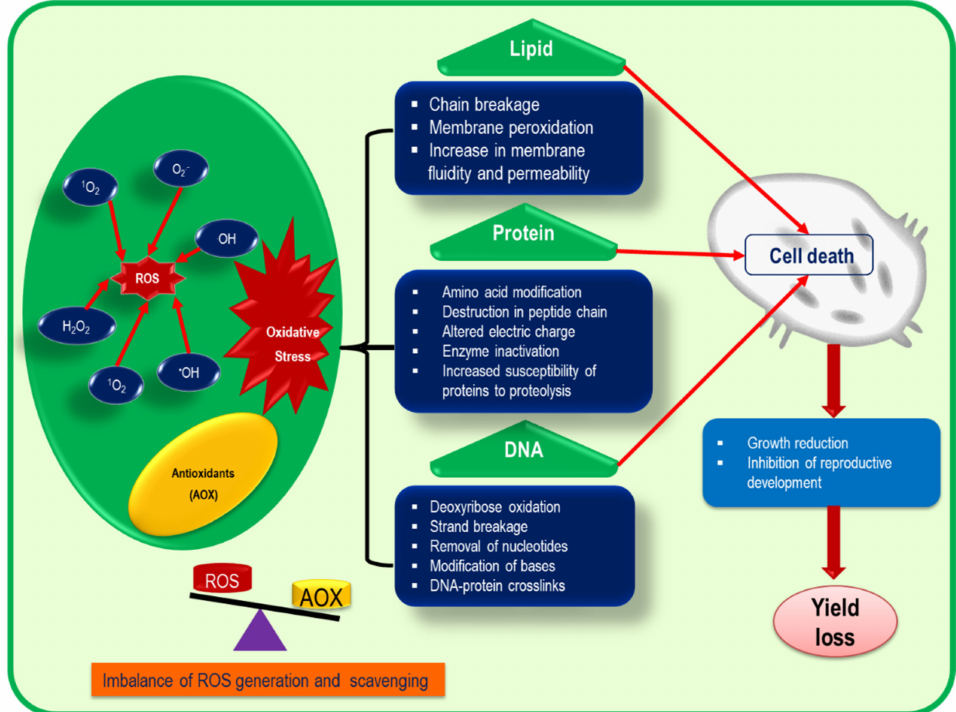
Figure 4. Consequences of oxidative stress on different cellular mechanisms. The imbalance between ROS production and scavenging creates oxidative stress in plants under abiotic stresses. As a consequence, different molecular and cellular damages occur that ultimately cause cell death. ROS—reactive oxygen species; AOX—antioxidants; H 2 O 2